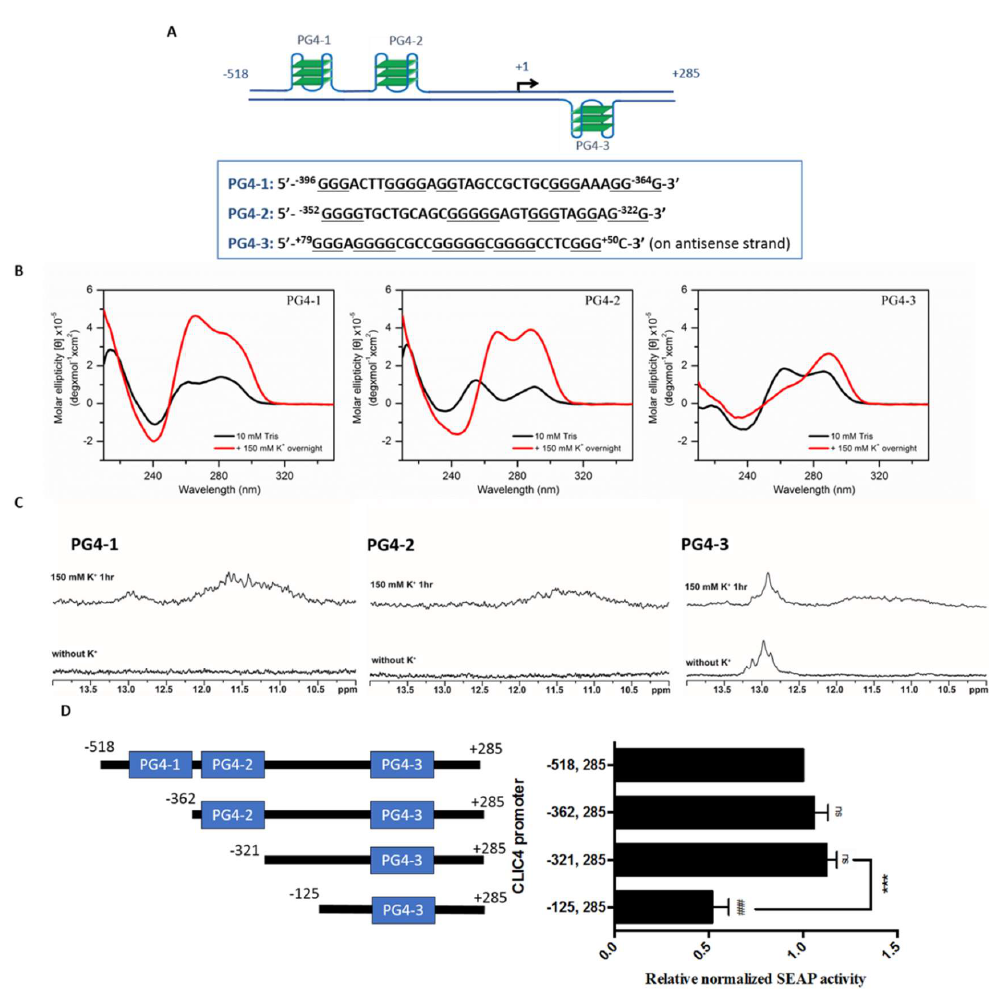
Figure 2. Putative G-quadruplexes (PG4s) in the CLIC4 promoter (−518, +285) ( A ) Schematic representation of three PG4s and their sequences in CLIC4 promoter. G-tracts that might participate in G4 formation were underlined; ( B ) The circular dichroism (CD) spectra of three PG4s in Tris-HCl buffer without (black line) and with (red line) 150 mM KCl for overnight; ( C ) The imino proton nuclear magnetic resonance spectroscopy (NMR) spectra of three PG4s in Tris-HCl buffer without (bottom panel) and with (top panel) 150 mM KCl for 1 h; ( D ) Progressive deletions of PG4s from the 5′-flanking regions in the CLIC4 promoter were generated in the pSEAP2-Basic reporter plasmid. A375 cells were transfected with each reporter plasmid for 48 h. Media were collected and subjected to SEAP activity measurements. Data were expressed as means ± SD of three replicates. ### p < 0.001, as compared to p(−518, +285). *** p < 0.001 as compared to the adjacent promoter region. ns: non-significant difference.